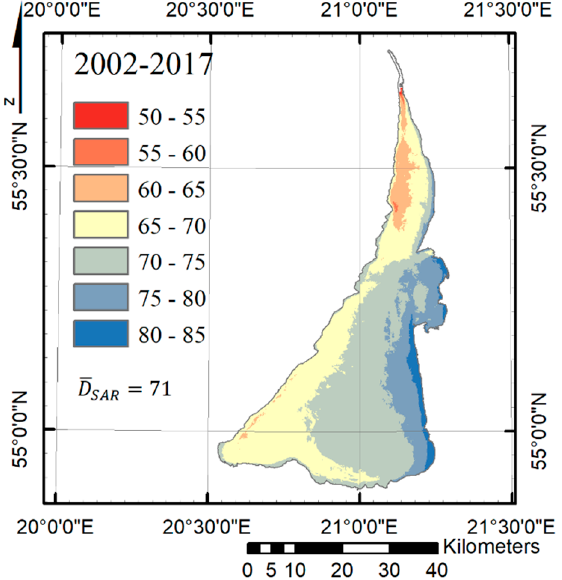
Figure 10. Yearly-mean ice season duration in the Curonian Lagoon as derived from the satellite data in 2002–2017.